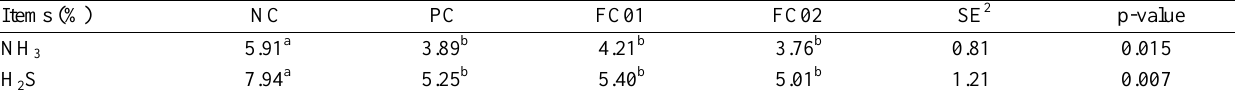
Table 6. Effect of fermented chlorella supplementation on fecal noxious gas content in growing pigs 1 Items (%) NC